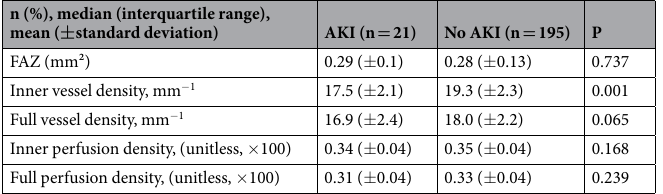
Table 3. OCT-A data. AKI: acute kidney injury; FAZ: foveal avascular